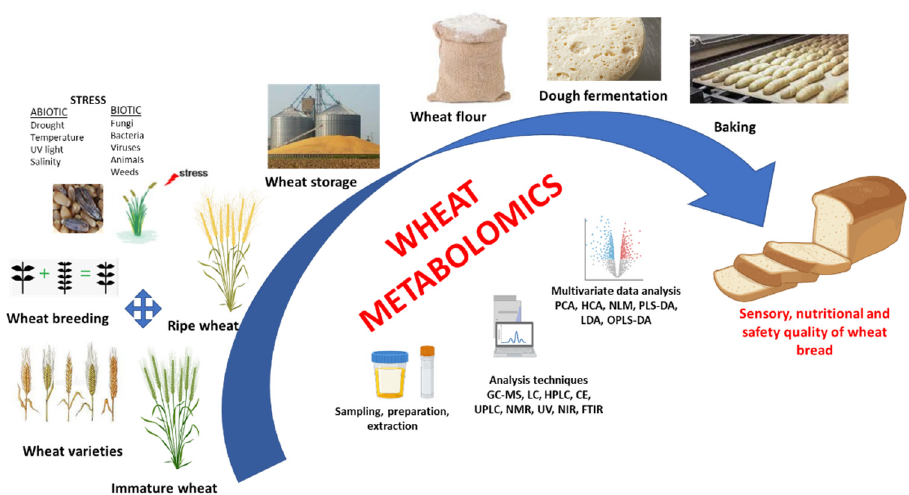
Figure Figure 1. Metabolomics as a tool to elucidate the sensory, nutritional and safety quality of wheat bread.